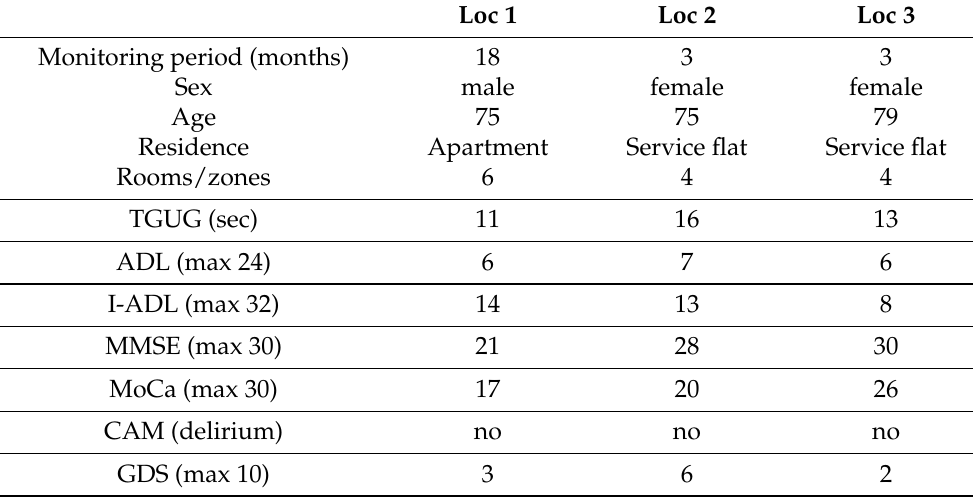
Table 2. An overview of the subjects and the scores of each administered clinical test at the start of the monitoring (TGUG (Timed-get-up-and-go) [23], Katz ADL (Katz Activities of Daily Living) [24], IADL (Instrumental Activities of Daily Living) [25], MMSE (Mini Mental State Examination) [22], MOCA (Montreal Cognitive Assessment) [27], GDS (Geriatric Depression Scale) [28], DI (Delirium Index) [29], and CAM (Confusion Assessment Method)